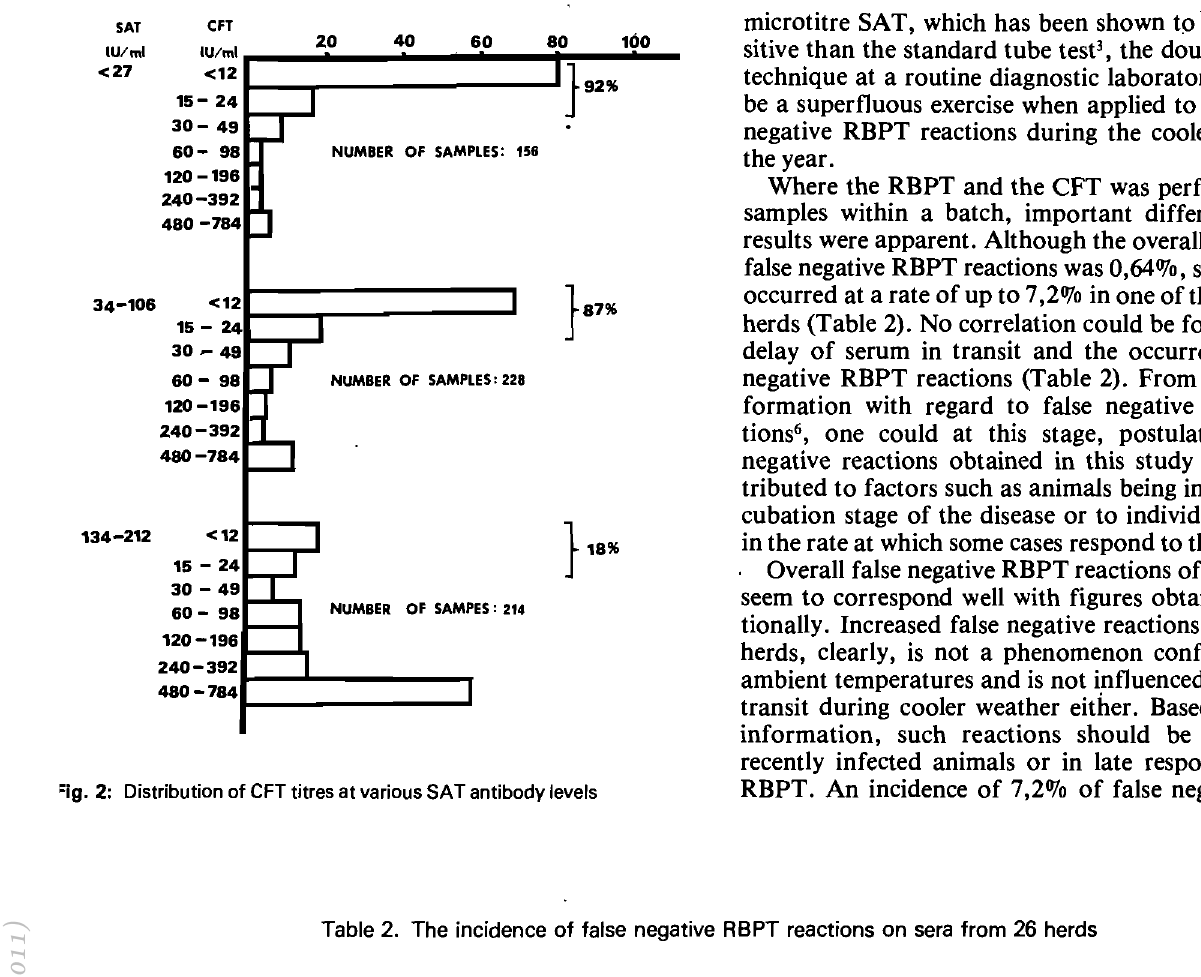
Table 2. The incidence of false negative RBPT reactions on sera from 26